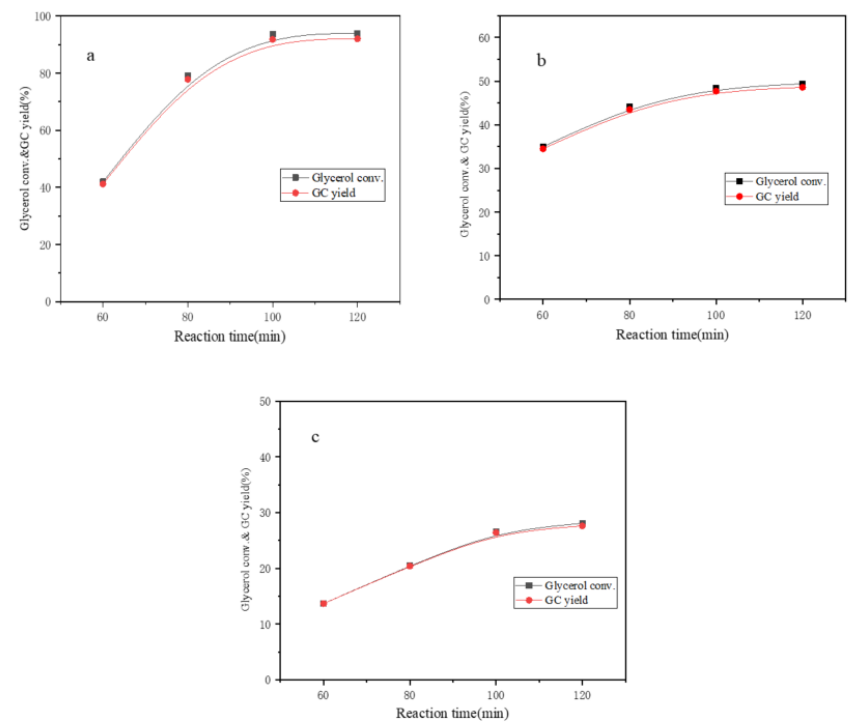
Figure 7. Glycerol conversion and GC yield catalyzed by β -CD-Ca/LDH ( a ), MgAl-LDH ( b ) and no catalyst ( c ).